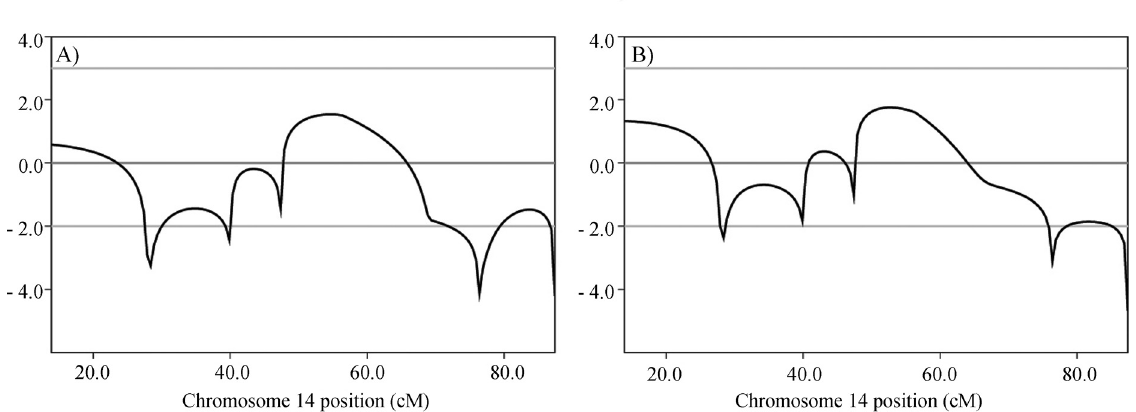
Figure 4 - Multipoint Lod Scores (on the Y-axis) obtained with microsatellite data for chromosome 14. A) Individuals marked with ? in Figure 1 were considered unaffected in this calculation; B) Individuals marked with ? in Figure 1 were considered affected by the same genetic disorder in this calcula- tion.